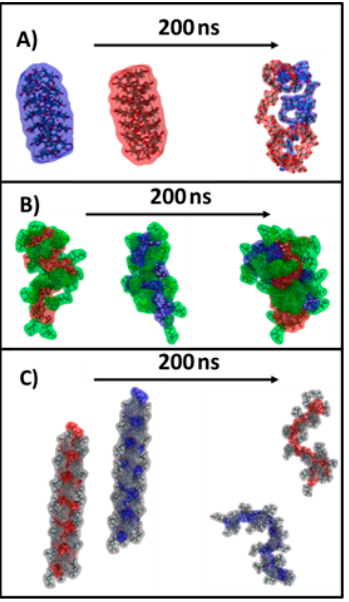
Figure 2. Snapshots depicting the starting and final structure of the 3 simulated systems: ( A ) amylose from starch, ( B ) SgAN and ( C ) SgAx. The starch molecules are colored in red and blue, the AN side chains are colored in green and the Ax side chains are colored in silver. Water has been omitted for clarity.